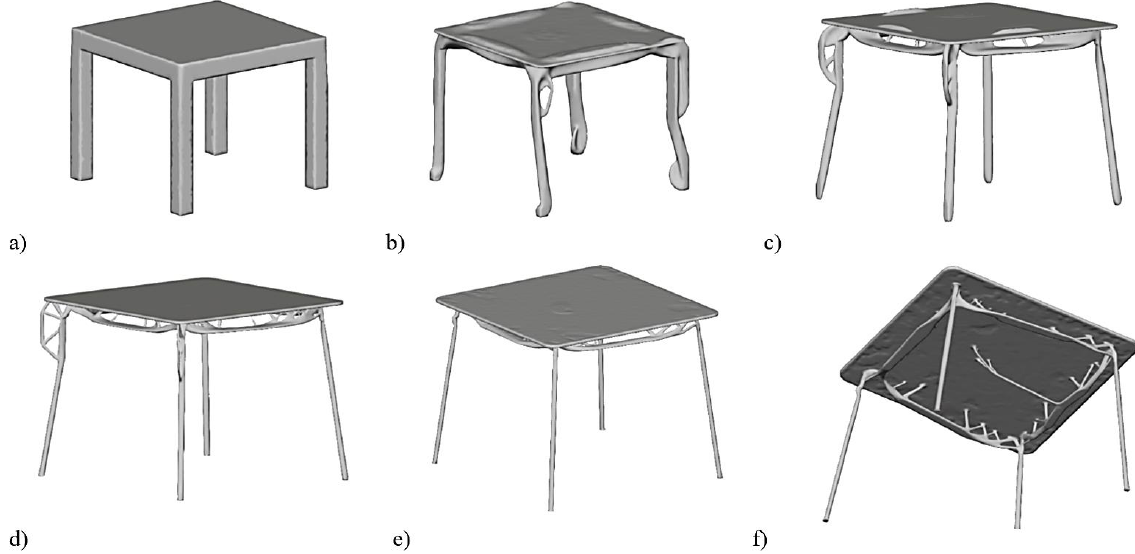
Figure 10. Material distribution during TO process. The algorithm starts from the initial model geometry (a) after 45 iterations the model_1 get the final optimized geometry (f), the intermediate model shapes are shown from (b) to (e).